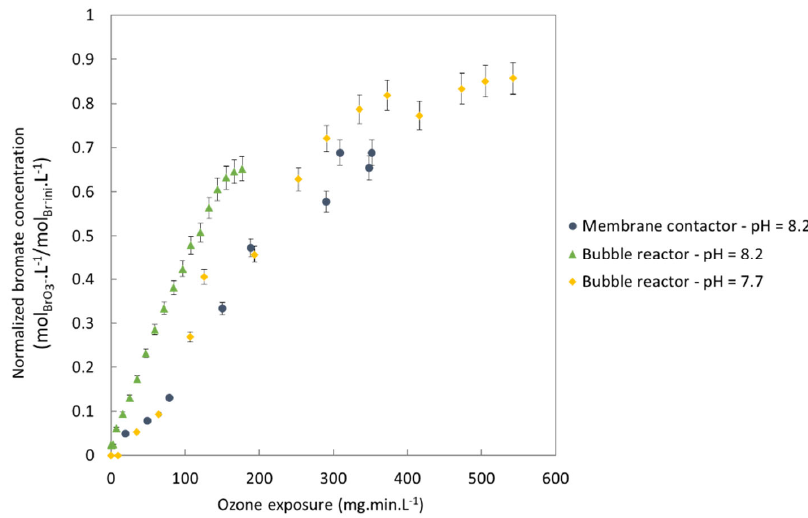
Figure 11. Normalized bromate concentration as a function of ozone exposure during ozonation with a membrane contactor at pH 8.2, a bubble reactor at pH 8.2 and a bubble reactor at pH 7.7. At identical ozone exposure, the semibatch reactor produced more bromates than the membrane contactor. One assumption that might explain this result is the local concentration of the dissolved ozone in the reactors. The bubble reactor is considered as perfectly stirred, leading to a fast homogeneous distribution of the ozone. In the membrane contactor, the dissolved ozone is very concentrated close to the fibers but varies significantly